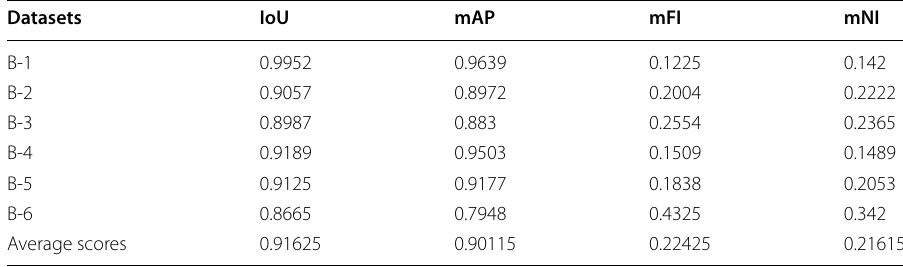
Table 1 Performance of B-MHAC on TRSE video datasets